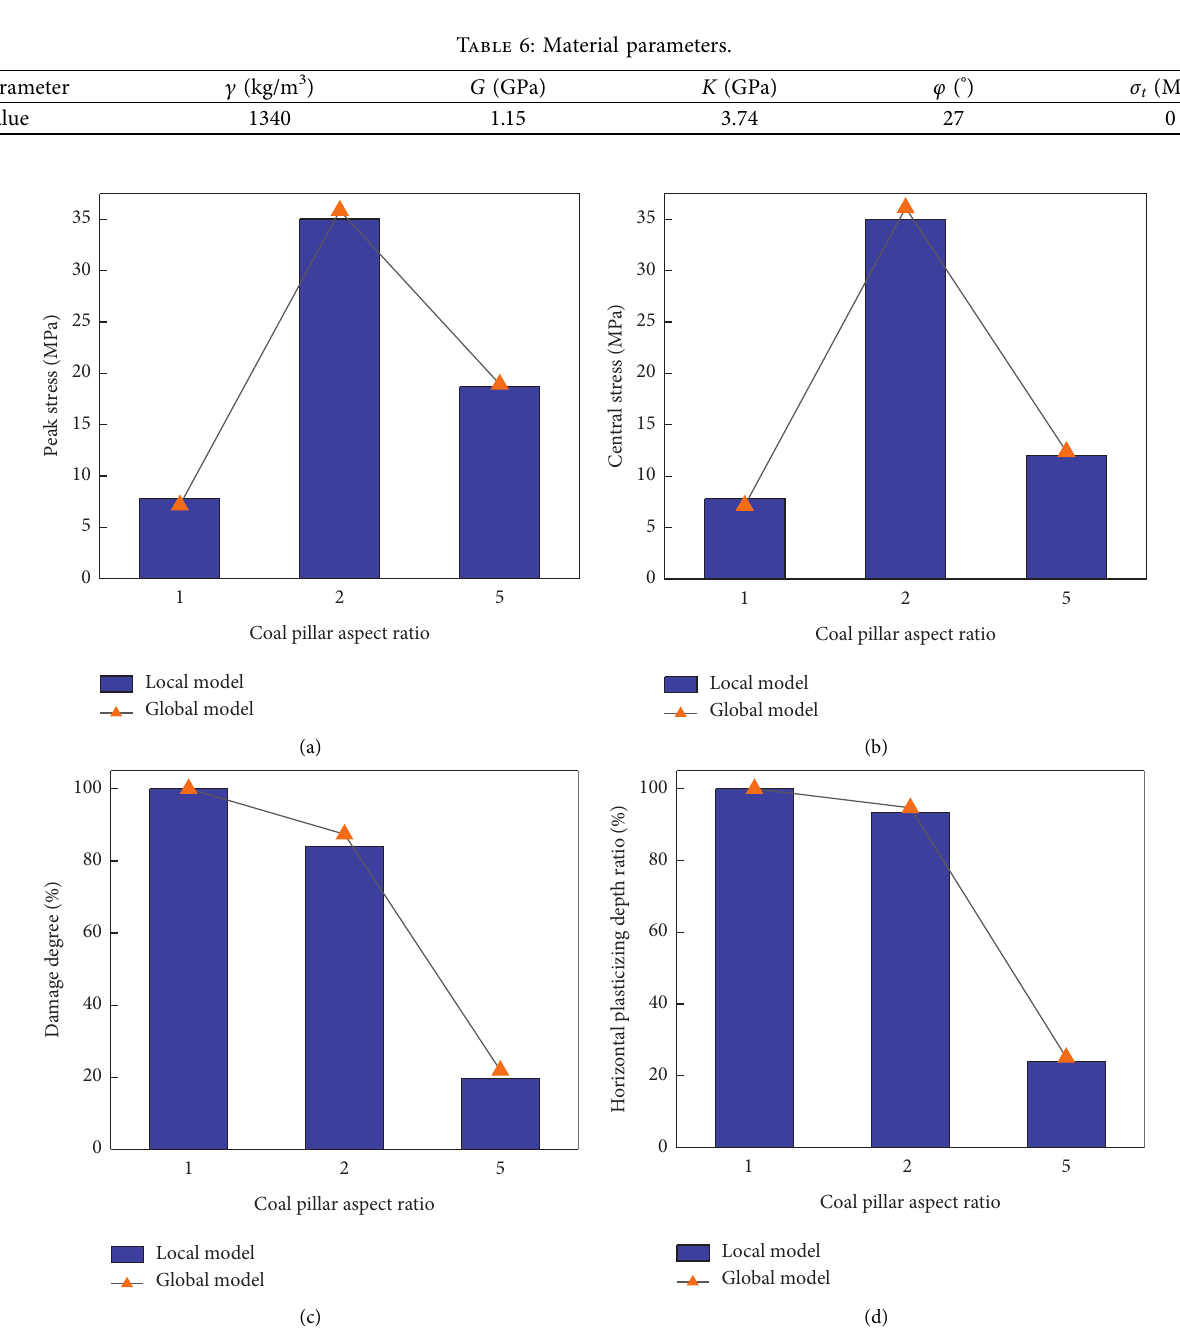
Figure 12: Comparison between local and global models. (a) Peak stress. (b) Central stress. (c) Damage degree. (d) Horizontal plasticizing depth ratio.